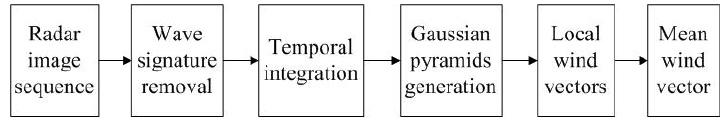
Figure 3. Flowchart of the optical flow motion estimation-based technique